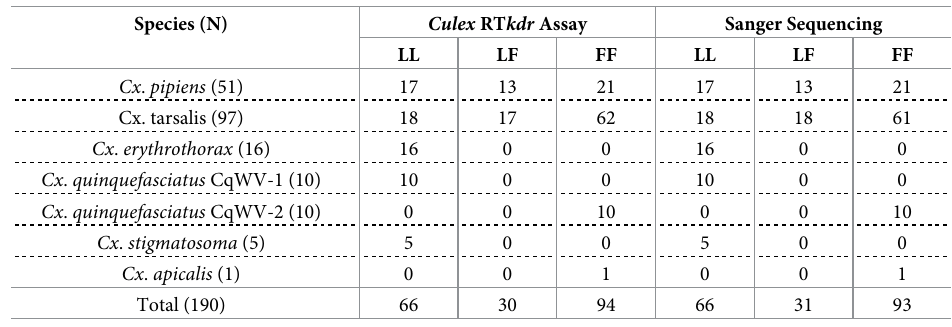
Table 4. Validating the Culex RT kdr assay by Sanger sequencing RT-PCR products. Homozygous LL-1014 (LL), heterozygous LF-1014 (LF), homozygous FF-1014